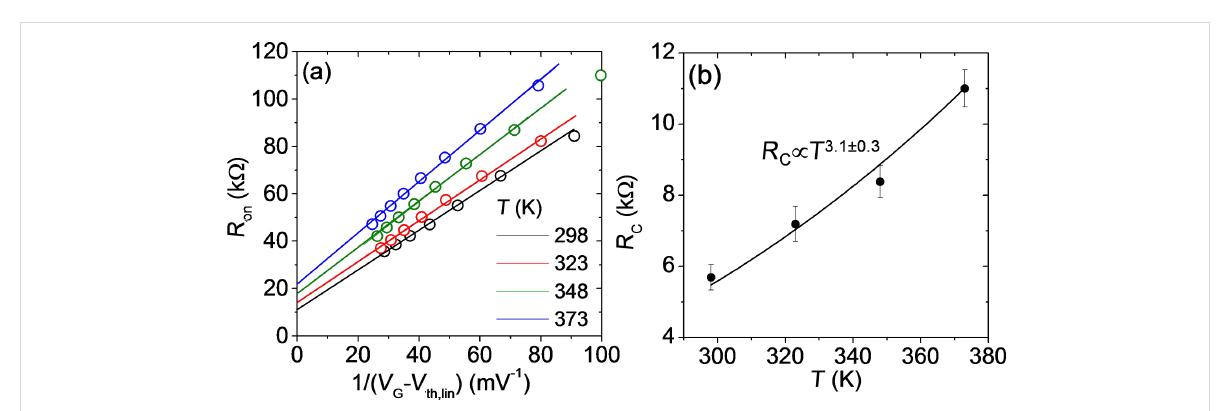
Figure 7: (a) On-resistance R on vs 1/( V G − V th,lin ) at different temperatures. (b) Temperature dependence of R C